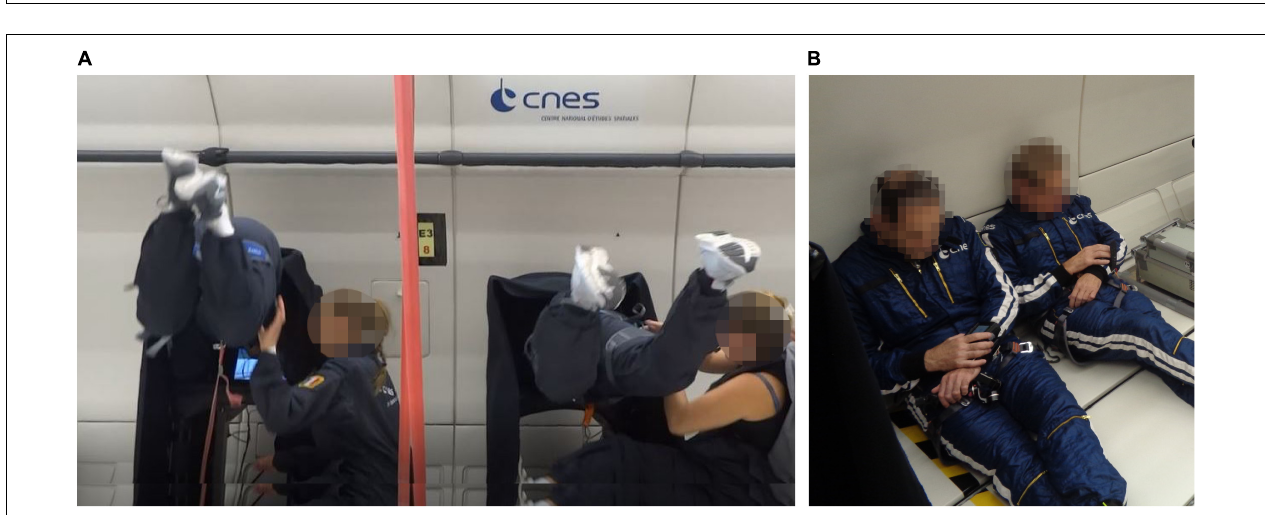
FIGURE 1 | Schematic overview of the study design. Four participants were tested on each flight day. MSSQ, Motion Sickness Susceptibility Questionnaire; POMS, Profile of Mood States; STAI Y-A/Y-B, State-Trait Anxiety Inventory Form Y Part A/B; CPT, Continuous Performance Task; PVT, Psychomotor Vigilance Task, Fam, familiarization session; VIS Morgen, sleep questionnaire; P, Parabola; syringe represents subcutaneous scopolamine injection.